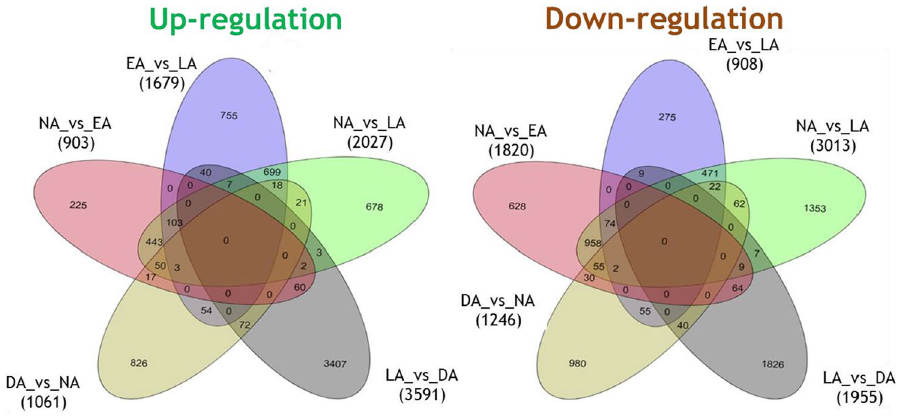
Figure 4. Venn diagram showing the ‘common’ and ‘specific’ differentially expressed genes [up-regulated (left) and down-regulated (right)] in pair wise comparison among the different acclimation phases. NA_vs_EA: regulation of genes during Early acclimation (EA) versus Non-acclimation (NA); EA_vs_LA: regulation of genes during Late acclimation (LA) versus EA; NA_vs_LA: regulation of genes during LA versus NA; LA_vs_DA: regulation of genes during De- acclimation (DA) versus NA and DA_vs_NA: regulation of genes during NA versus